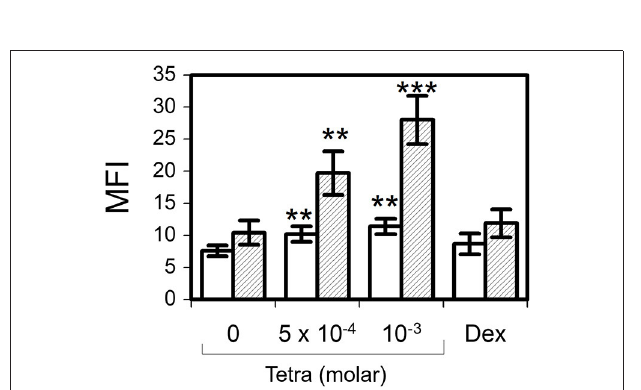
FIGURE 5 | Tetracycline hydrochloride induced intracellular hydrogen peroxide production. In contrast to dexamethasone 10 − 6 M (Dex) tetracycline hydrochloride (Tetra) induced apoptosis was accompanied by a significant intracellular production of H 2 O 2 after 2h (unfilled bars) and 24h (striped bars). Dihydrorhodamine assay, mean fluorescence intensity (MFI) ± SEM ( n = 7). ** p < 0.01, *** p < 0.001. least IL-5 is known to prolong eosinophil survival via inhibition of caspases (55). Using a pan-caspase inhibitor (zVAD-fmk) our experimental data showed that tetracycline hydrochloride- induced eosinophil apoptosis was caspase dependent.